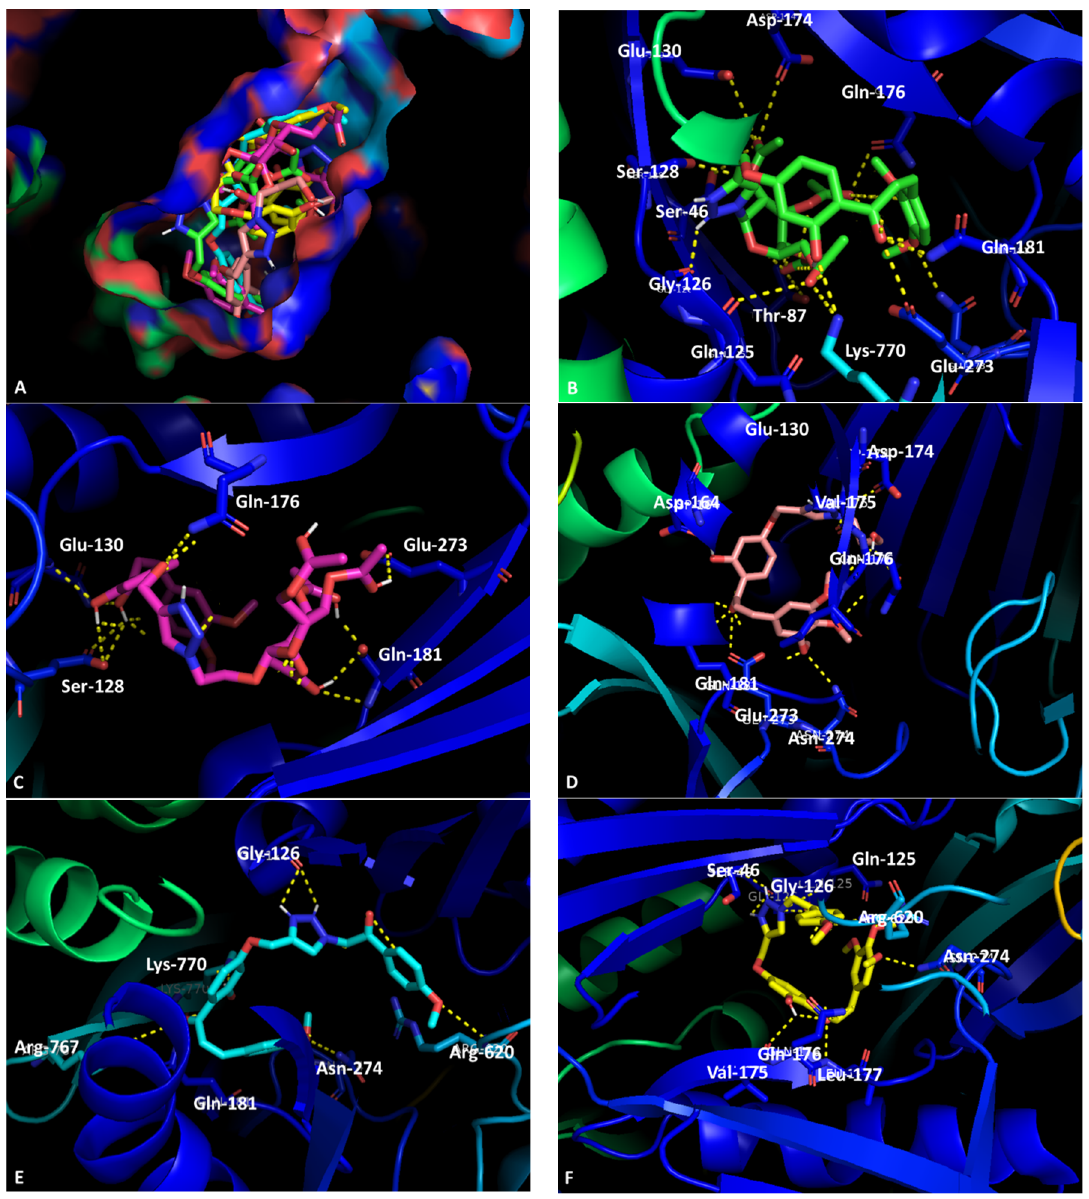
Figure 2. Molecular visualization of chalcones in the SBS of the AcrB portion of the AcrAB-TolC efflux system. ( A ) General view of compounds in the SBS (surface view); ( B ) interaction between compound 3 (green) and the SBS; ( C ) interaction between compound 5 (pink) and the SBS; ( D ) interaction between compound 6 (magenta) and the SBS; ( E ) interaction between compound 7 (blue) and the SBS; ( F ) interaction between compound 8 (yellow) and the SBS.